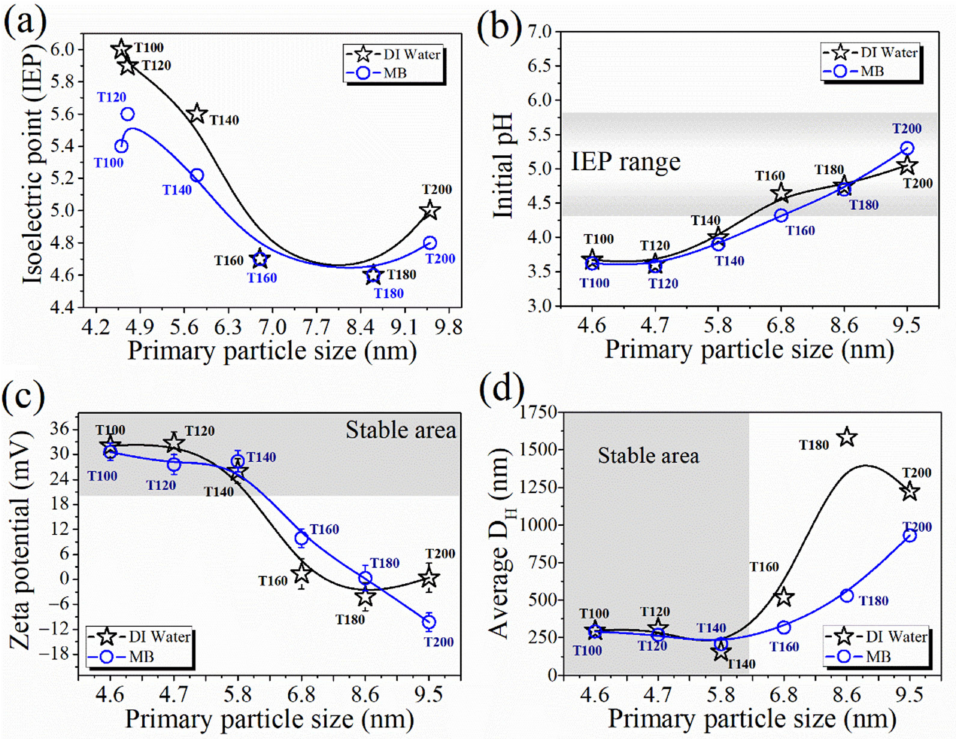
Figure 6. The influence of the primary particle size of as-dispersed TiO 2 NPs in DI water and with MB on the ( a ) IEP, ( b ) initial pH, ( c ) ζ -potential, and ( d ) average D H (secondary particle